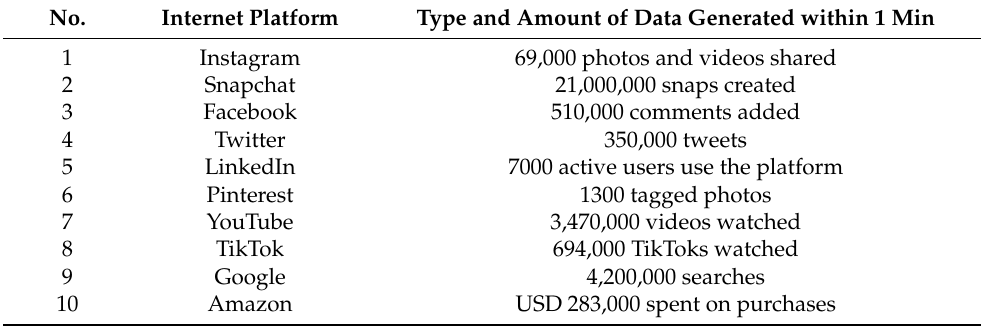
Table 1. Data collected by online platforms in one minute,